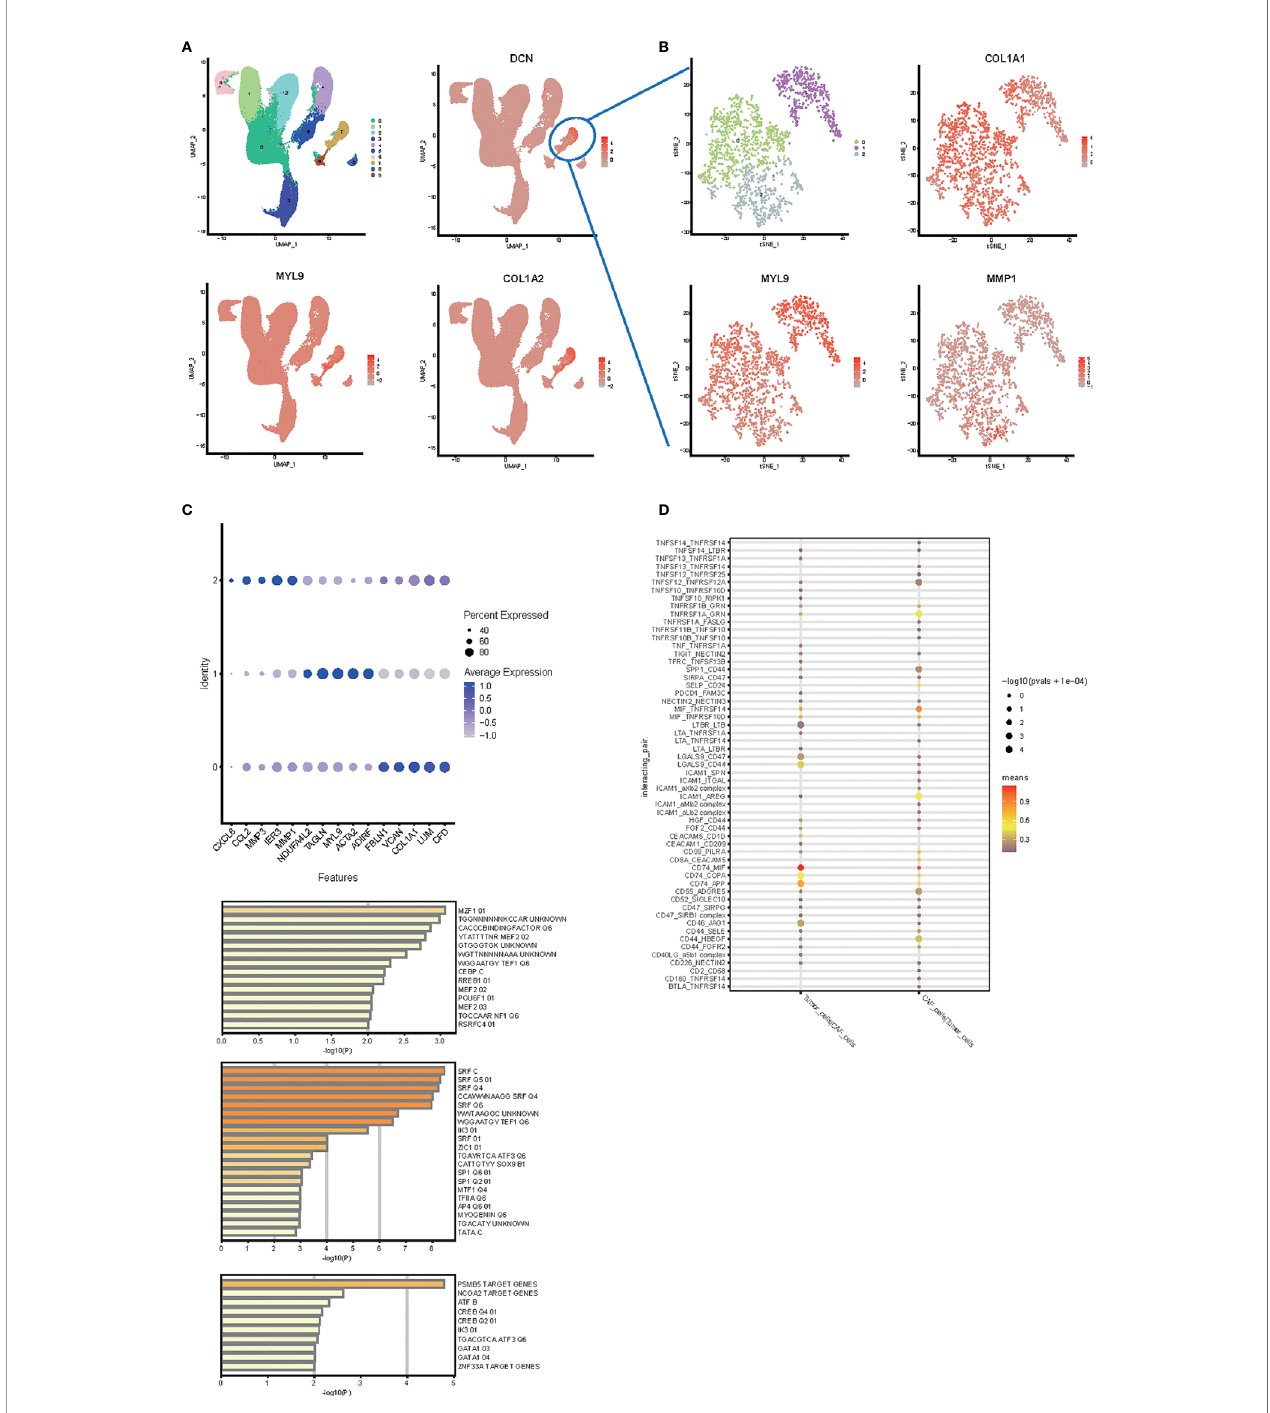
FIGURE 6 | Single cell RNA-seq analysis in human colon cancer samples. (A) UMAP plot and clustering analysis. The color map showed clusters, and the markers of CAF were plotted on the map ( DCN, MYL9, COL1A2 ). Cluster 2 was identi fi ed as cancer cells and cluster 7 was identi fi ed as CAF. (B) t-SNE plot and clustering analysis for CAF subtype. The color map showed clusters, and the markers of each CAF subpopulation were plotted on the map ( MMP1, MYL9, COL1A1 ). (C) Bubble plots express different marker genes according to each cluster high speci fi c expression gene separate different cells of CAF. (D) Transcription factor analysis from metascape. The fi rst 50 genes of each CAF subpopulation were used to analyze the transcription factors speci fi cally regulated. (E) Cell interaction between CAF and tumor